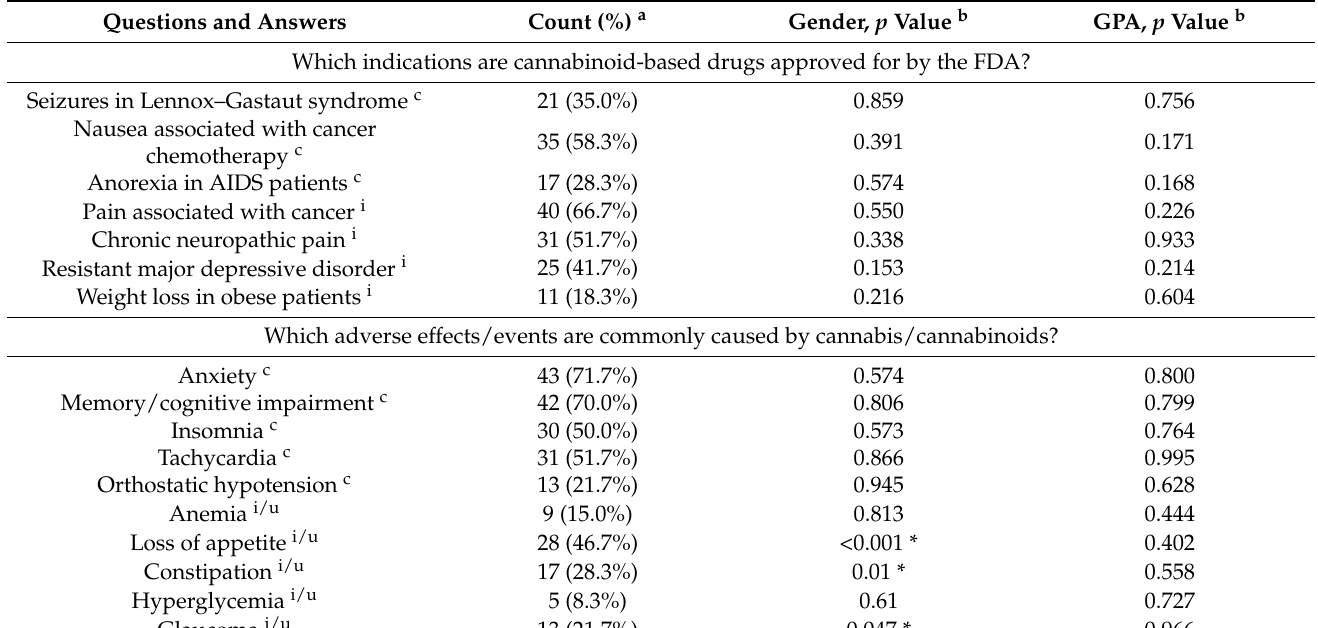
Table 5. Participants’ knowledge of medicinal cannabis and cannabinoid